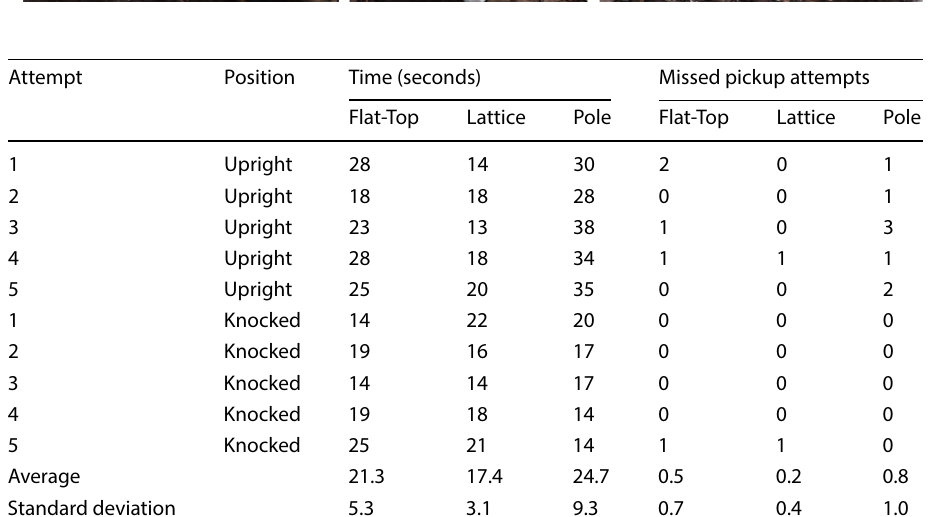
Attempt Position